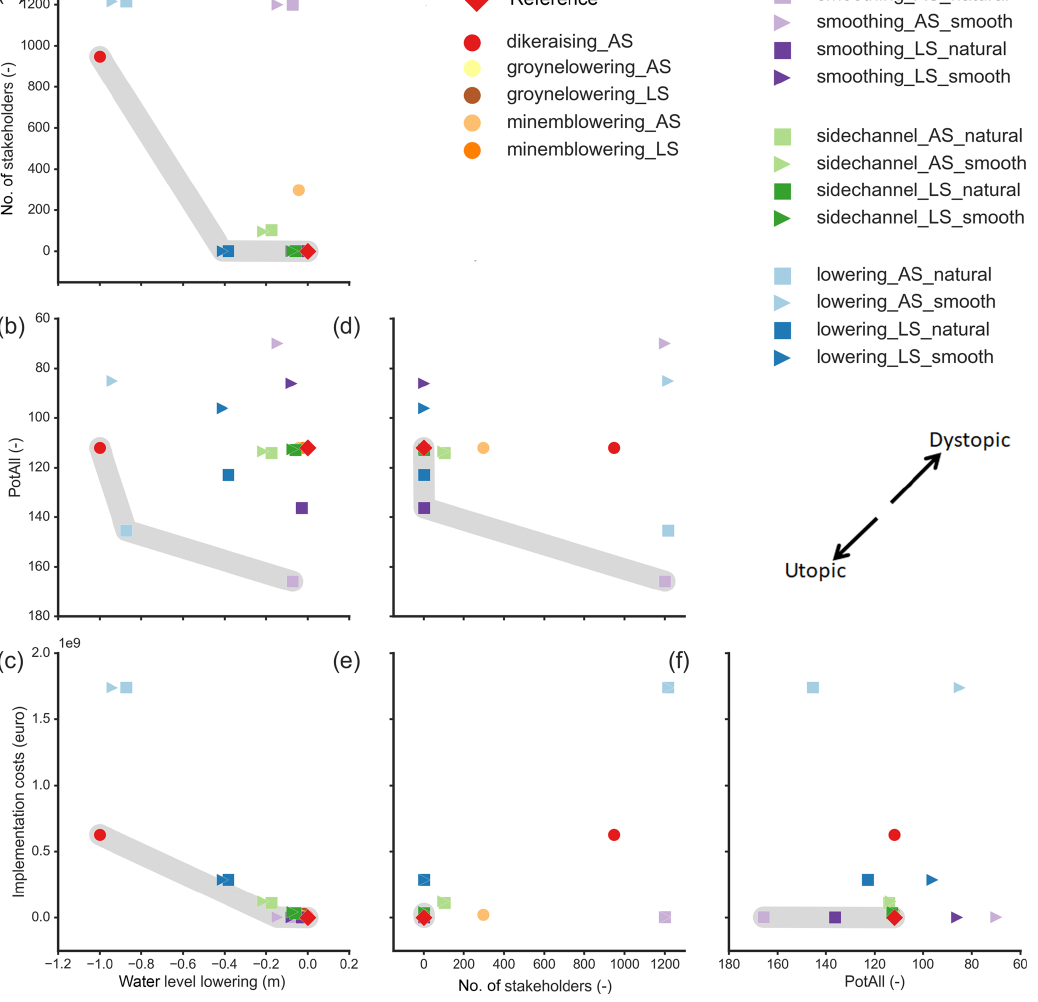
Figure 9. Scatterplot matrix of the main criteria for intervention planning. The grey areas indicate the optimum combination of criteria for each panel. Similar colors represent one type of measure, and shading represents the difference in location. The two design principles are visualized, with a rectangle for natural and a triangle for smooth. The diamond represents the reference